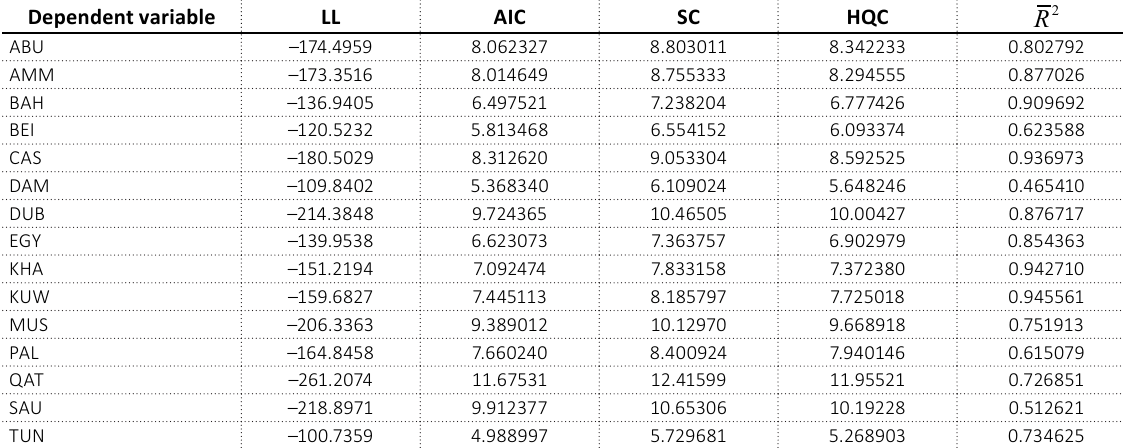
Table 9. Summary results of model estimation, Model 4: Component GARCH